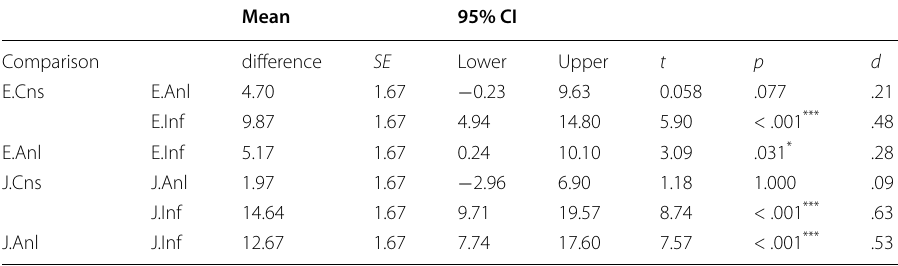
Table 5 Post hoc comparisons between three CT skills in each ECTT and